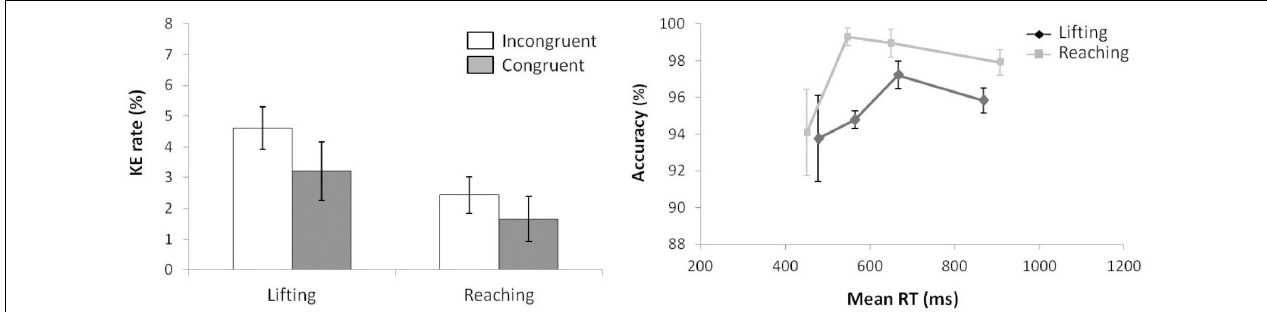
FIGURE 5 | (Left) Interactions of movement × congruence with respect to kinematic error rate. (Right) Delta-plots showing conditional accuracy functions for incongruent trials as a function of response speed (expressed in reaction time quartiles) for lifting action (gray square) and reaching action (black circle) in Experiment 2. Error bars represent the standard error of the